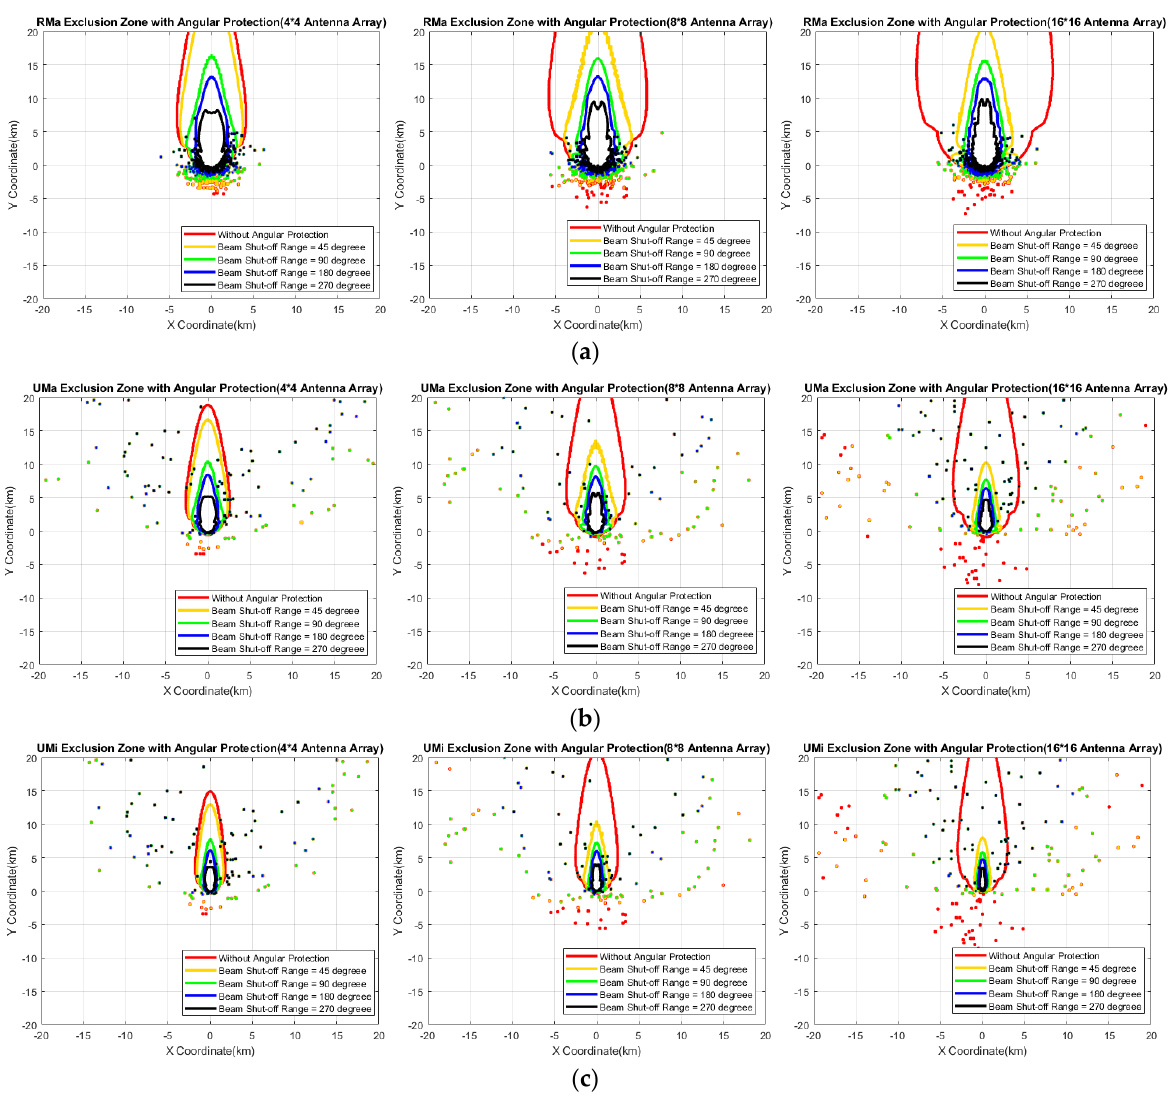
Figure 11. Reduction in the exclusion zone using the proposed angular protection for various an- tenna types. ( a ) Rural macrocell (RMa); ( b ) urban macrocell (UMa); ( c ) urban microcell (UMi).